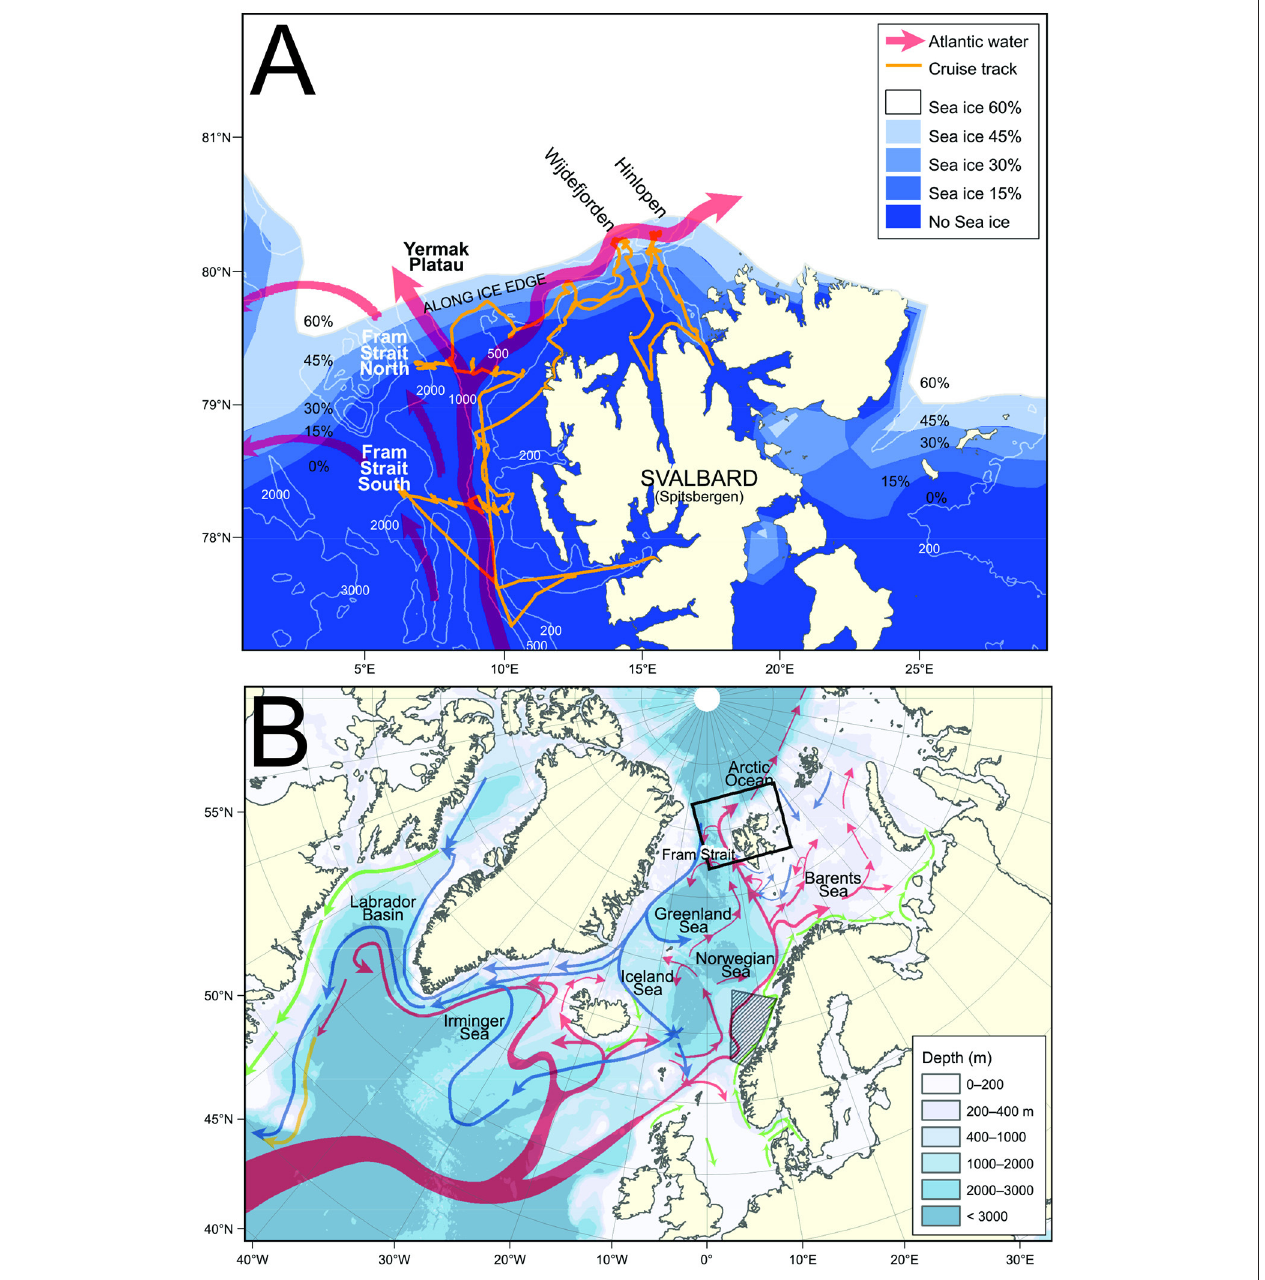
FIGURE 1 | (A) Details of Fram Strait and Svalbard archipelago including bathymetry, main Atlantic currents, average sea ice concentration during the survey and cruise track with names of transects. (B) Bathymetric map of the Northern Atlantic with major currents superimposed. Hatched region refers to area covered by transects t1–t9 of Melle et al.